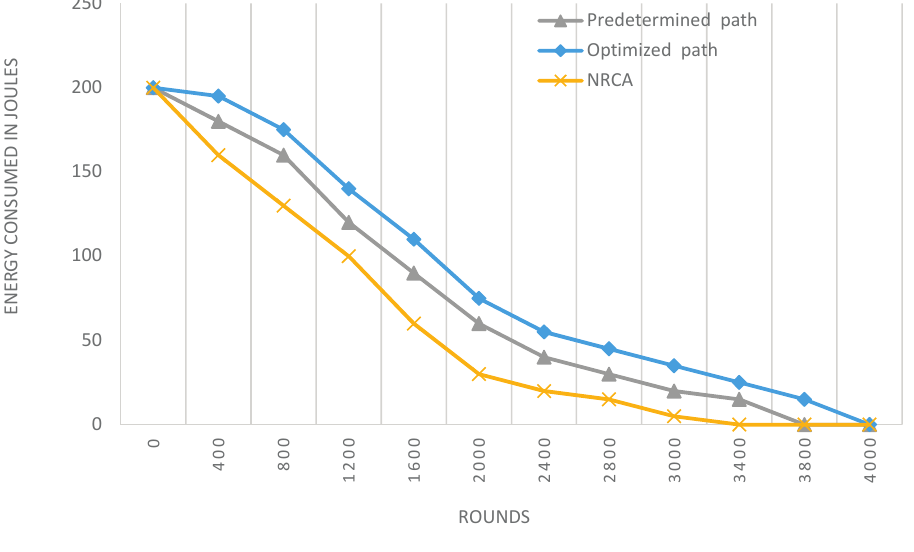
Figure 3. Energy consumption in the network.